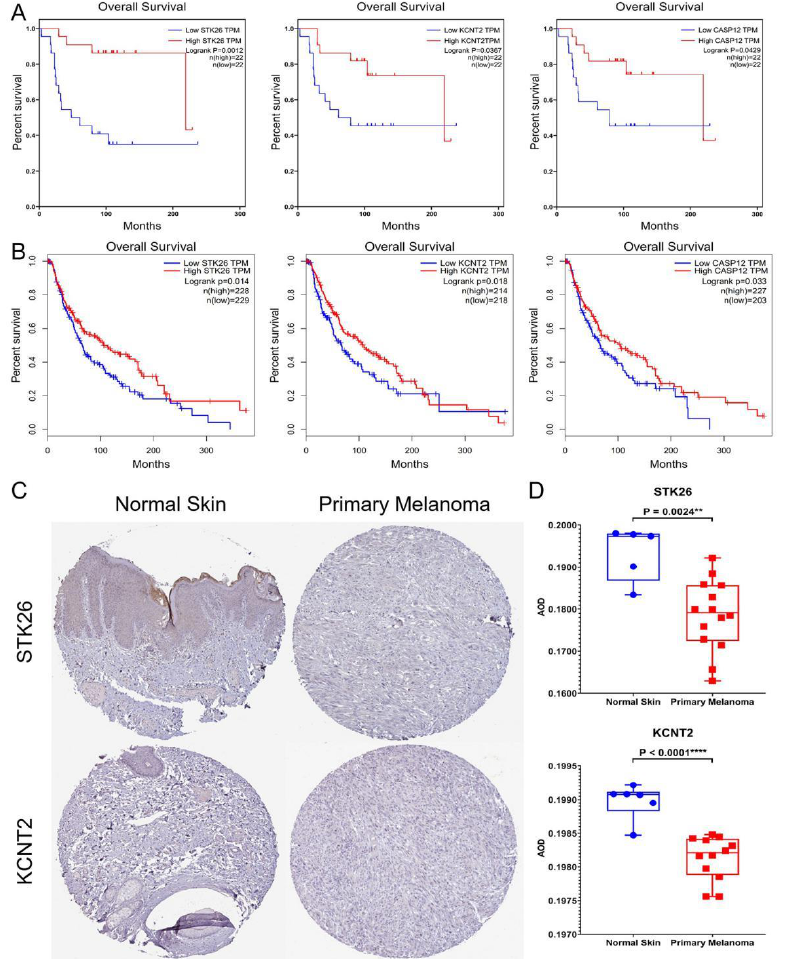
Figure 5. Hub gene identification and validation. ( A ) Overall survival of the three hub genes in skin cutaneous melanoma based on the GSE98394 datasets. The patients were stratified into high-level group and low-level group according to median expression. ( B ) To identify hub genes by the GEPIA database. The patients were stratified into high-level group and low-level group according to median expression. ( C ) Immunohistochemistry of STK26 and KCNT2 based on the Human Protein Atlas. ( D ) Gray-scale analysis revealed statistically significant differences in the protein expression of STK26 ( P = 0.0024) and KCNT2 ( P < 0.0001) between normal skin and melanoma.